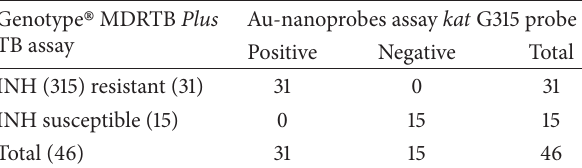
Table2:MDR-TBmemberdetectionusingtheAu-nanoprobeassay. Test results from the Au-nanoprobes assay were subsequently com- pared with results from the Genotype MDR-TB Plus assay.